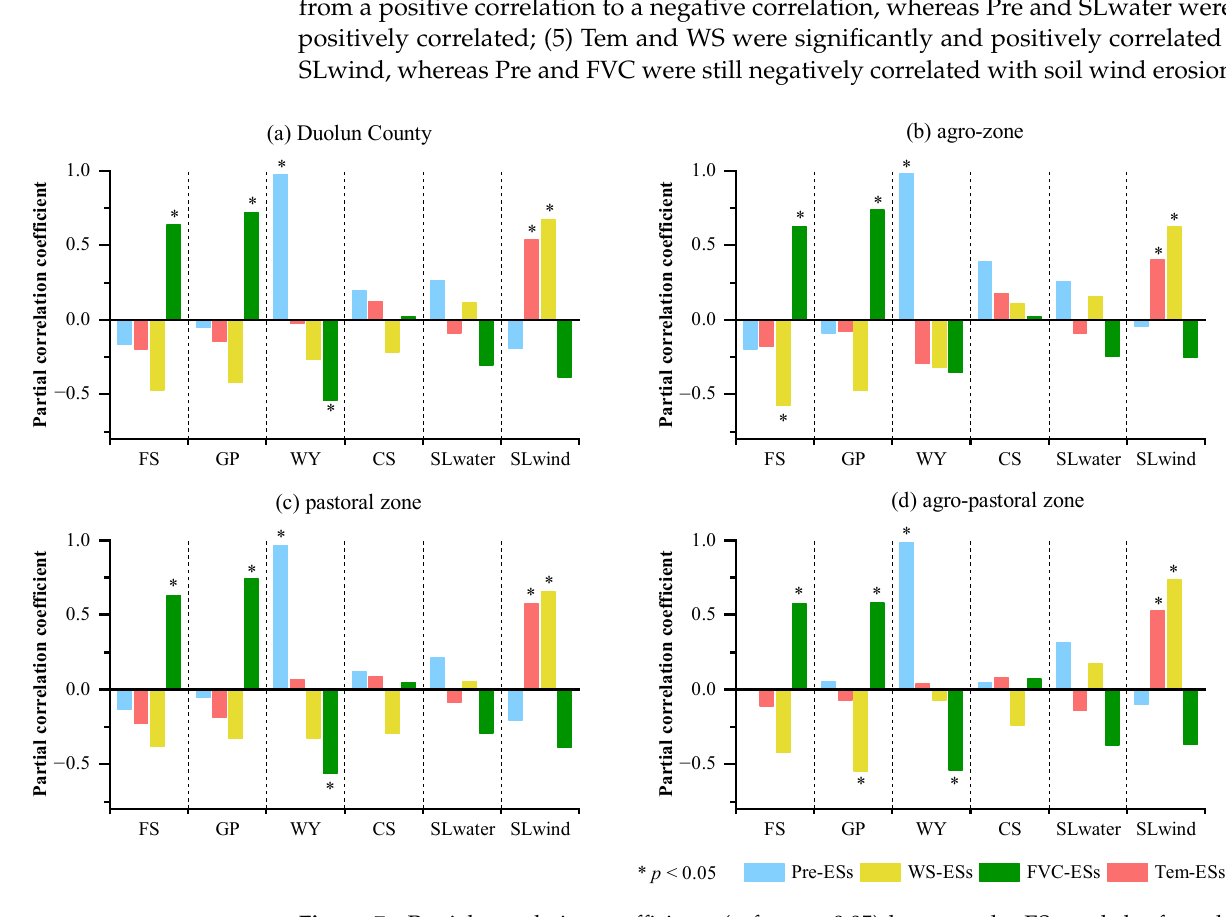
Figure 7. Partial correlation coefficients ( ∗ for p < 0.05) between the ESs and the four drivers (vegetation cover (FVC), precipitation (Pre), temperature (Tem), and wind speed (WS)) in different regions from 2000 to 2017. ( a ) Partial correlation coefficients in Duolun County, ( b ) partial correlation coefficients in the agricultural advantage zone (agro-zone), ( c ) partial correlation coefficients in the pastoral advantage zone (pastoral zone), ( d ) partial correlation coefficients in the semiagricultural and semipastoral zone (agro-pastoral zone). FS: food supply, GP: grass production, WY: water yield, CS: carbon sequestration, SLwater: soil water erosion, SLwind: soil wind erosion.